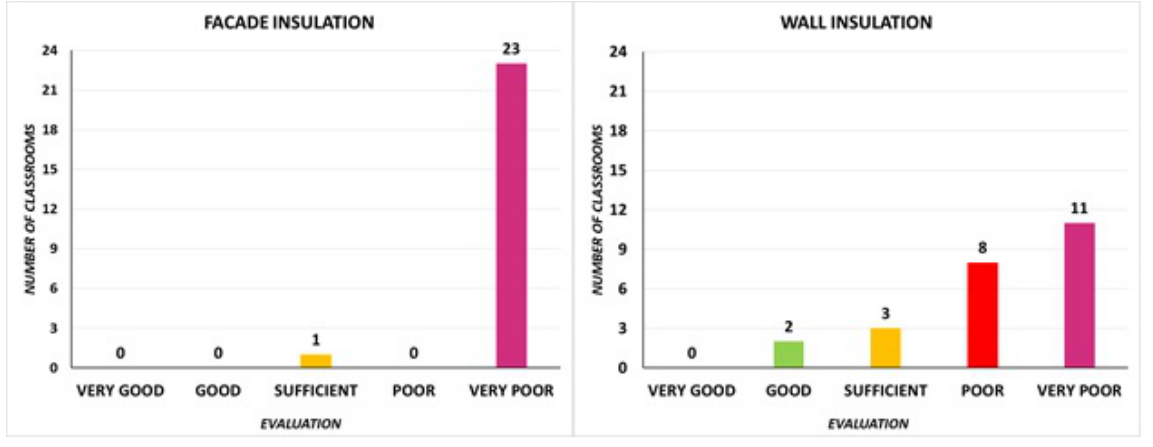
Figure 3: Insulation of the vertical